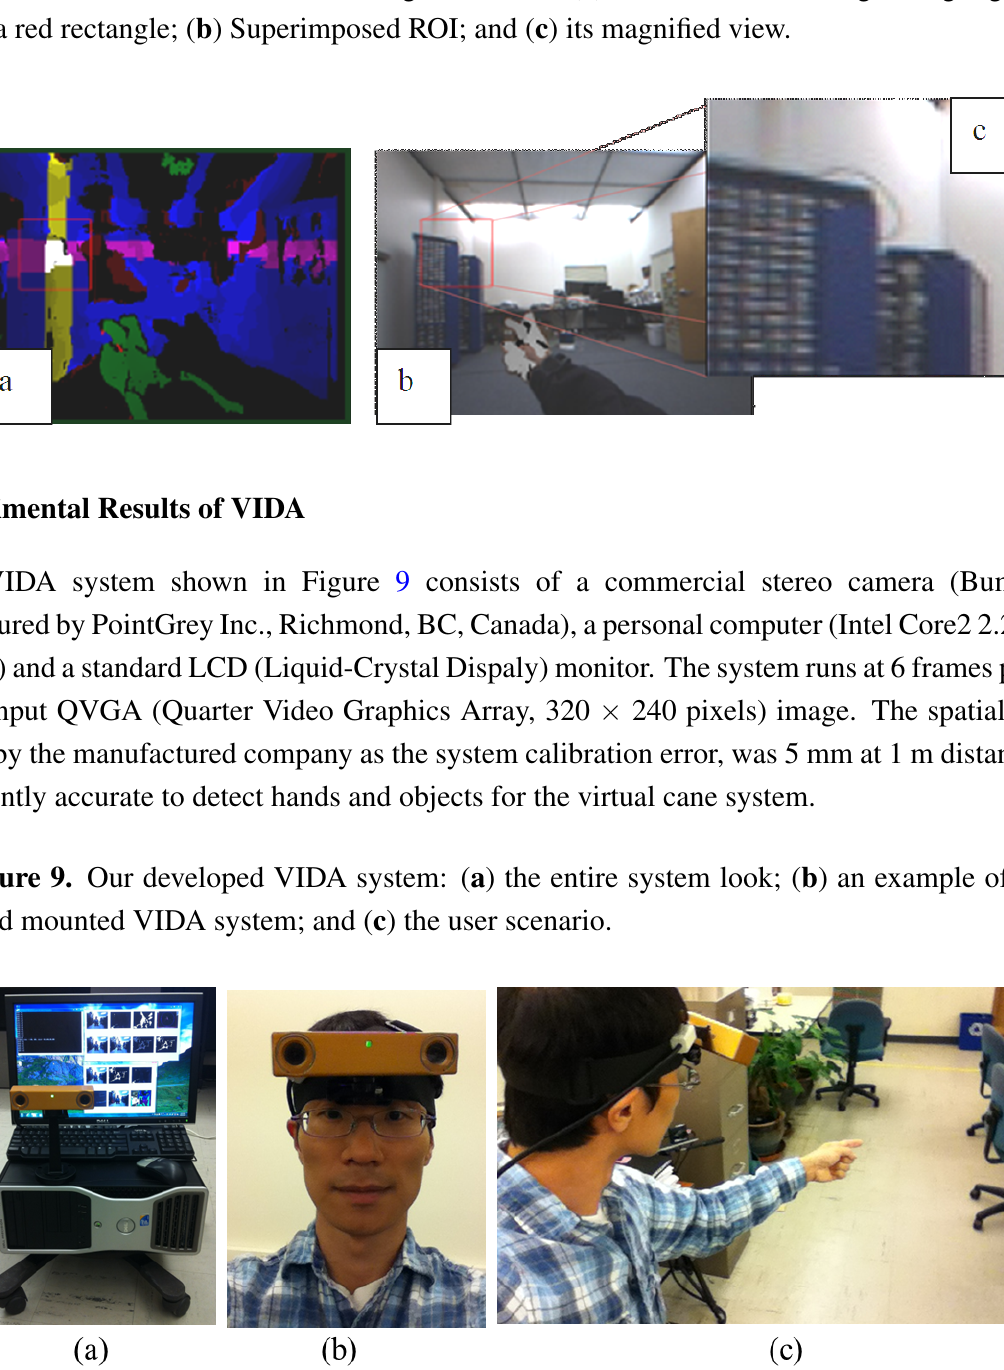
Figure 8. ROI extraction and the magnified view: ( a ) the extracted ROI region highlighted by a red rectangle; ( b ) Superimposed ROI; and ( c ) its magnified view.